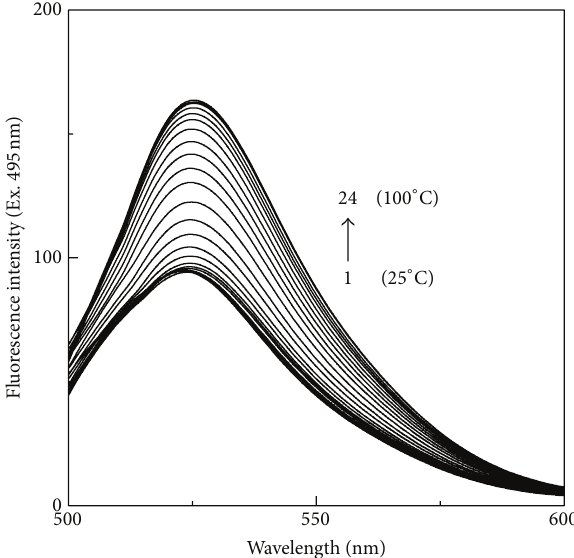
Figure 4: Fluorescence spectra of 0.50 𝜇 M FITC-BSA obtained at increasing temperatures in the range of 25–100 ∘ C upon excitation at 495 nm. Different temperatures ( 1 → 24 ) used were: 25, 30, 35, 40, 45, 50, 52.5, 55, 57.5, 60, 62.5, 65, 67.5, 70, 72.5, 75, 77.5, 80, 82.5, 85, 90, 95, 97.5 and 100 ∘